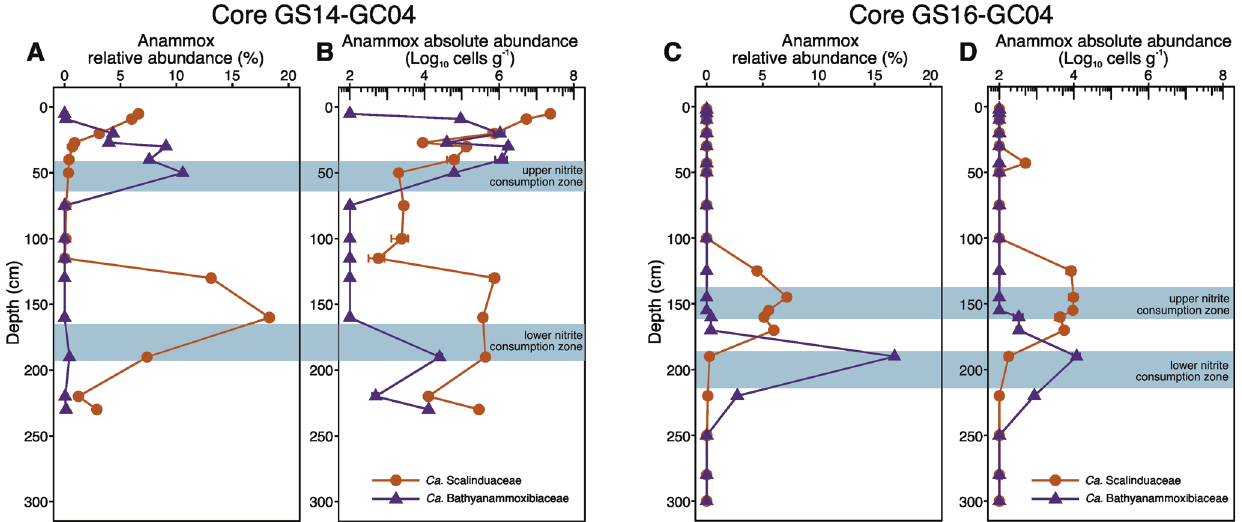
Fig. 4 Niche partitioning of anammox bacterial families in GS14-GC04 and GS16-GC04. Relative abundances of the anammox families ( Ca . Scalinduaceae and Ca . Bathyanammoxibiaceae) throughout cores GS14-GC04 ( A ) and GS16-GC04 ( C ), as assessed by 16 S rRNA gene amplicon sequencing. Absolute abundances of the two anammox families in cores GS14-GC04 ( B ) and GS16-GC04 ( D ), calculated as the product of the total cell numbers times their relative abundances in the total communities. Panels ( C , D ) are replotted from ref.